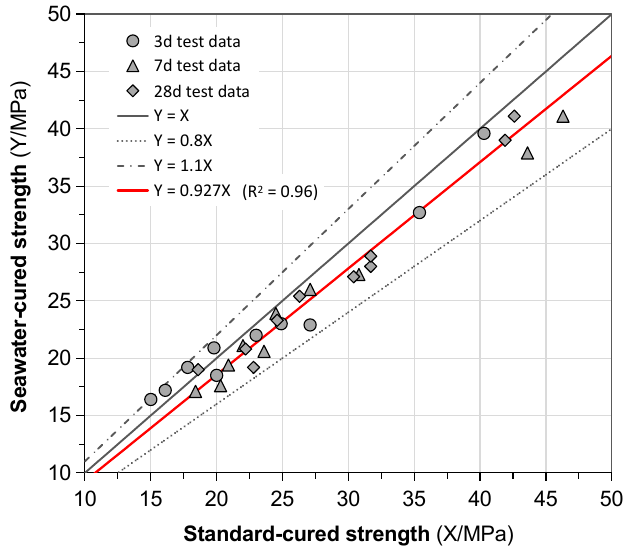
Figure 11. Correlating compressive strength of GPC immersed in artificial seawater to its counterpart stored in standard condition.